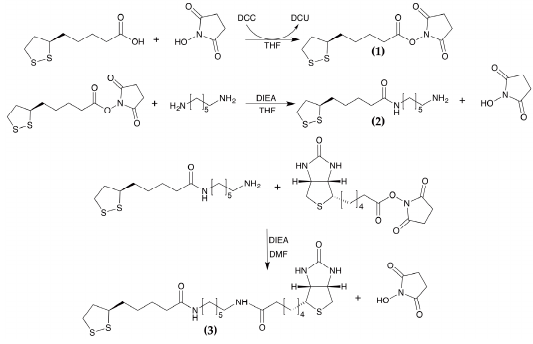
Figure 3. Reaction scheme for the synthesis of the biotinylated linker.